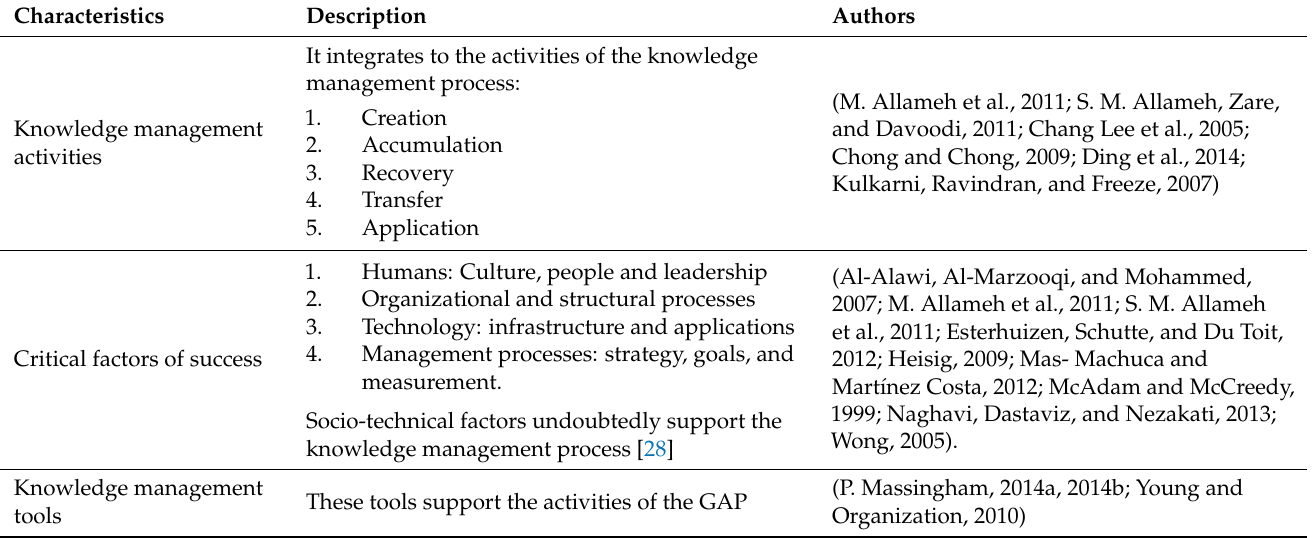
Table 3. Characteristics found in knowledge management